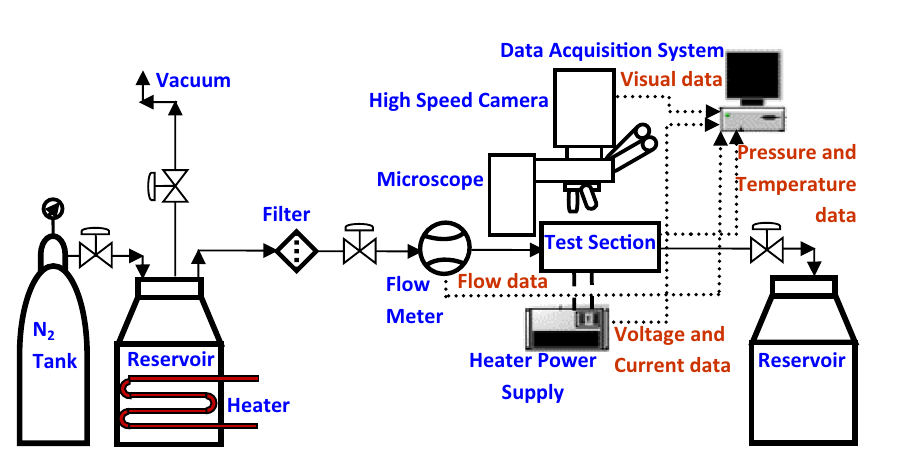
Figure 2. Schematic diagram of flow loop with high speed camera and data acquisition system 40